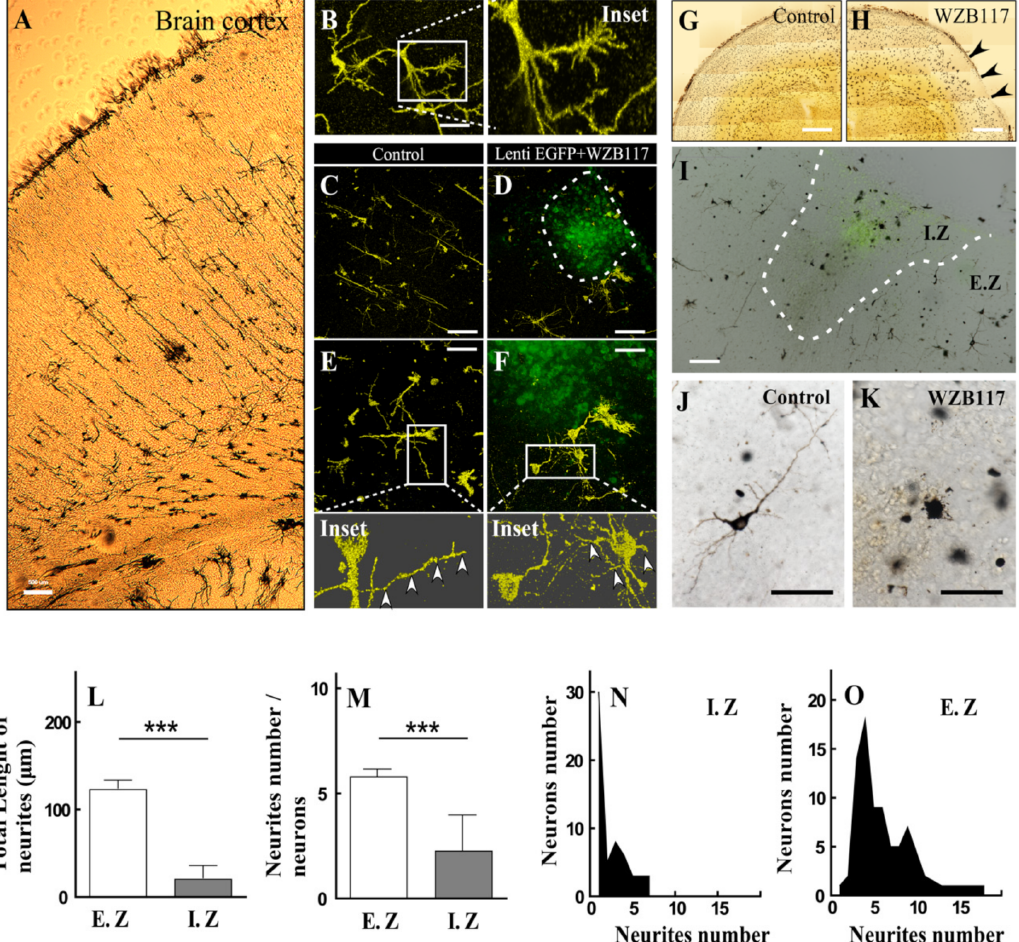
Figure 7. Golgi–Cox impregnation and confocal-reflection microscopy in postnatal rat cerebral cortex injected with lentivirus-EGFP and treated with WZB117. ( A ) Optic microscopy analysis of the outer cerebral cortex in 8 days of postnatal development rat brain after URG impregnation. ( B ) Confocal reflection microscopy (CRM) and 3D-Z-stack analysis of neuronal morphology of URG-impregnated neuronal cells. ( C , E ) Control cerebral cortex with URG-impregnation and CRM ( C , E and inset). ( D , F ) Cerebral cortex treated with WZB117 and lentivirus-EGFP (depicted area in D ) for 72 h and analyzed with URG-impregnation and CRM ( D , F and inset). Neuronal neurites were analyzed with Z-stack-3D (Insets and arrows head). ( G , H ) Control rat brain ( G ) from 8 days of postnatal development or injected with 10 µ M WZB117 for 72 h ( H , arrows head) analyzed with impregnation with Golgi–Cox and Tile-scan reconstruction. ( I ) Brightfield microscopy analysis mixed with an epifluorescence image in the same area injected with lentivirus-EGFP and WZB117 (I. Z and depicted zone). The brain area most distant from the injection site was called E. Z. ( J ) Representative image of neurons present in the E. Z. ( K ) Representative image of neurons present in the I. Z. ( L ) Quantification of the total length of neurites quantified in neurons analyzed in the E. Z and I. Z. ( M ) Comparative analysis of the number of neurites quantified per neuron in the E. Z and I. Z. ( N , O ) Frequency graph of the number of neurites in the I. Z. and E. Z, respectively. Statistical analysis t-student (*** p < 0.001). Graph shows mean + SEM. In total, 30–40 neurons were quantified per area. Scale bars, in A, 500 µ m; in ( B ), 15 µ m; in ( C , D ), 250 µ m; in ( E , F ), 150 µ m; in ( G , H ), 1 mm; in I, 100 µ m; in ( J , K ), 30 µ